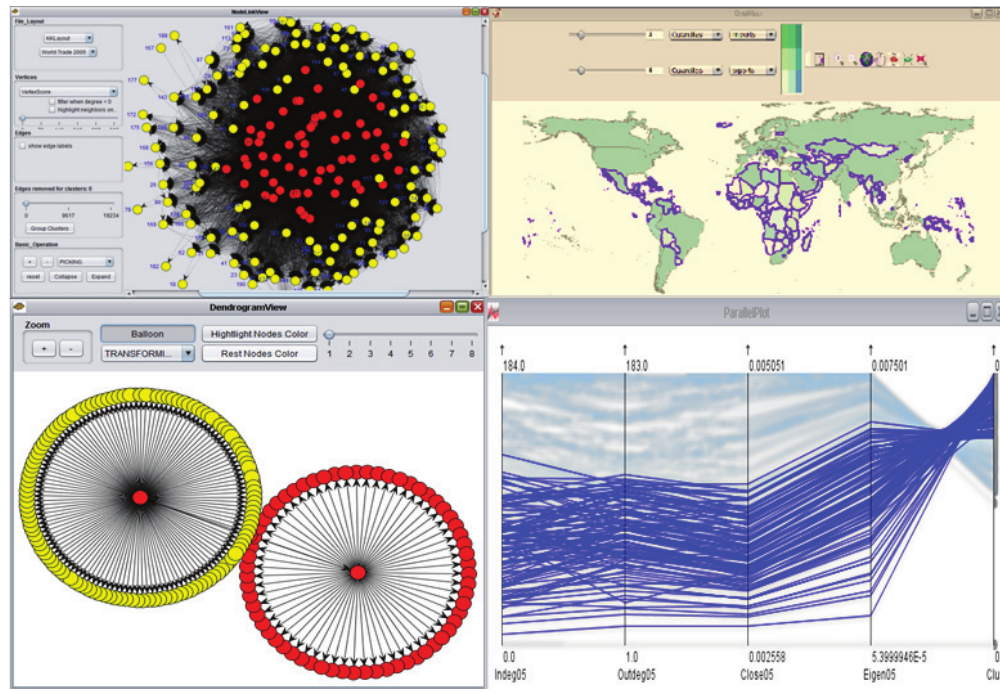
Figure 4: The analysis of international trade data among 192 countries in 2005 with GeoSo- cialApp: node-link (upper left), dendrogram (lower left), bivariate choropleth map (upper right) and parallel coordinate plot (lower right). For a preliminary view of this tool, see Luo, et al. [127]. Each node in the node-link view and the dendrogram view corresponds to one country in the bivariate choropleth map; the parallel coordinate plot view is used to explore network attributes for countries (from left to right, the attributes depicted are: indegree, outdegree, closeness, eigenvector, and clustering coefficient). Red dots in the node-link and dendrogram view are periphery countries and these are highlighted on the map and parallel coordinate plot with blue